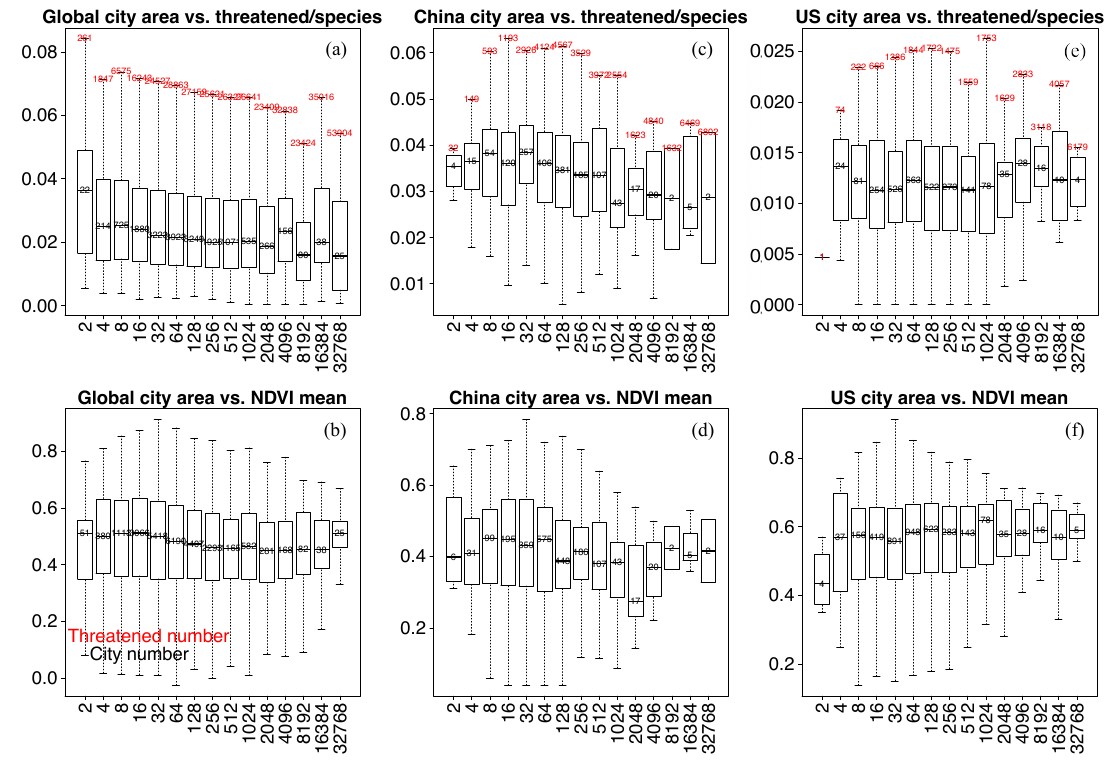
Figure 7. Statistics of city size versus threatened species indicator (upper row) and averaged vegetation greenness (NDVI, bottom row) for the ( a , b ) Globe, ( c , d ) China and ( e , f ) America. City sizes are binned into exponentially wider bins to circumvent the situation that few numbers of cities appear in large city size ranges (city size in km 2